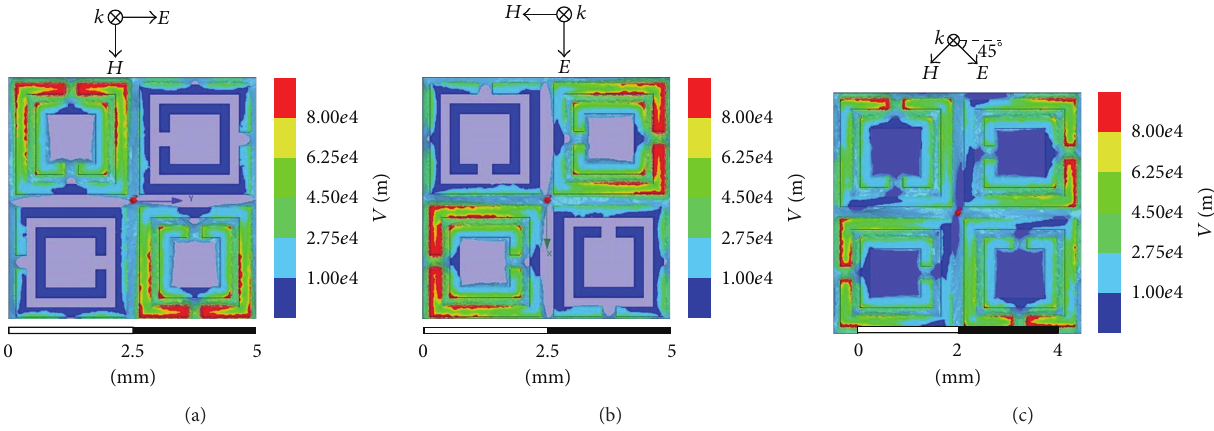
Figure 5: Electric field distribution at 10.27 GHz for (a) normal incident TE, (b) normal incident TM, and (c) 45 ∘ incident waves.